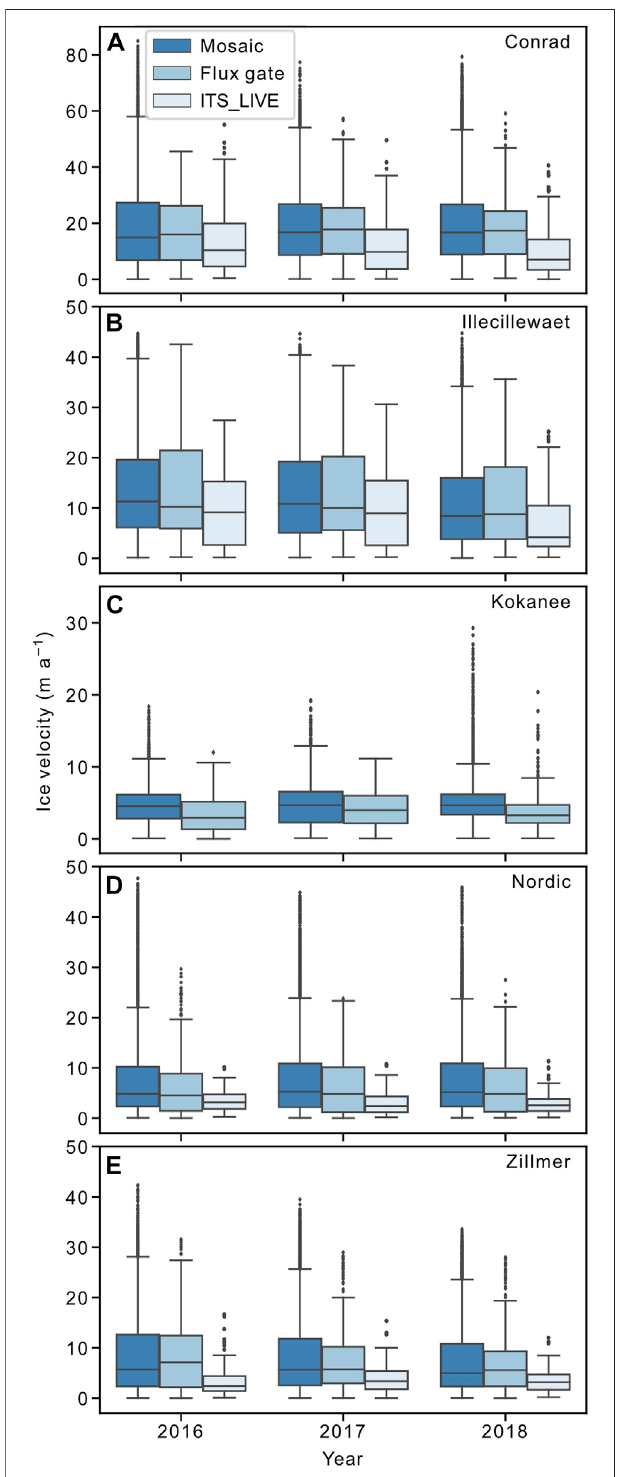
FIGURE 5 | Surface ice velocity of each glacier from mosaics of our feature-tracking-derived annual velocity mosaics, for those mosaics as sampled along fl ux gates, and from ITS_LIVE annual mosaics. Boxplots depict 95% con fi dence interval (whiskers), interquartile (IQR) range (box), and median